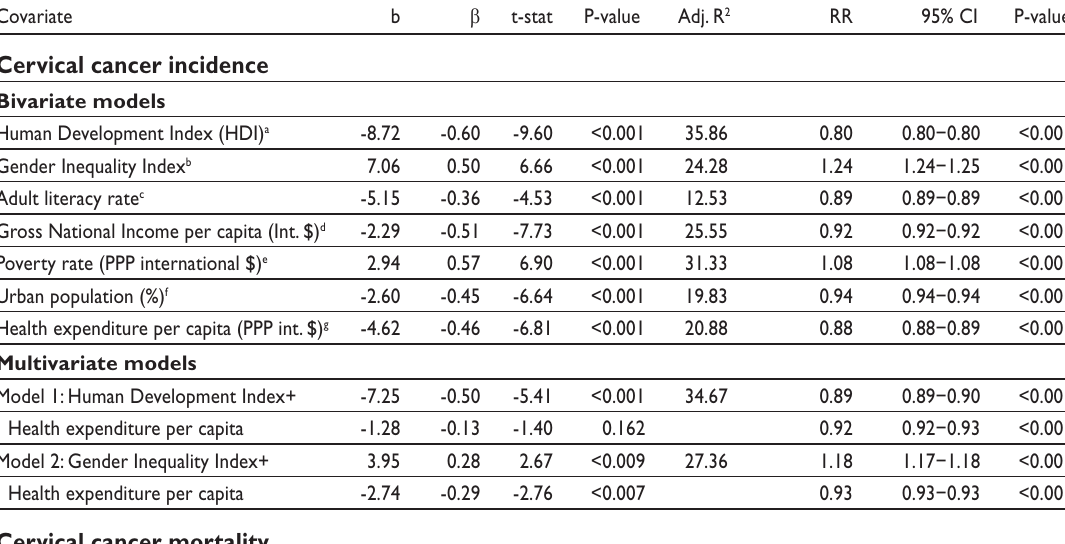
Table 2. Ordinary Least Squares (OLS) and Poisson Regression Models Showing the Effects of Human Development Index, Gender Inequality Index, and Socioeconomic and Health Care Factors on Age- Adjusted Cervical Cancer Incidence and Mortality Rates, 2008 (N = 184 Countries) OLS Models Poisson Models Covariate t-stat P-value Adj. R